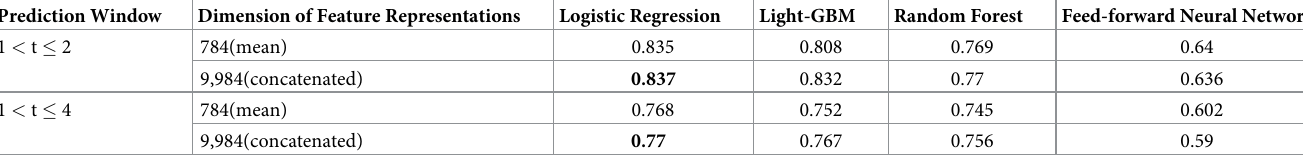
The columns show the comparison among the models, and the rows show the comparison among two variants of dimensions in PubMedBERT features. The bold numbers indicate the highest AU-ROC scores and the best performing models for both short-term prediction